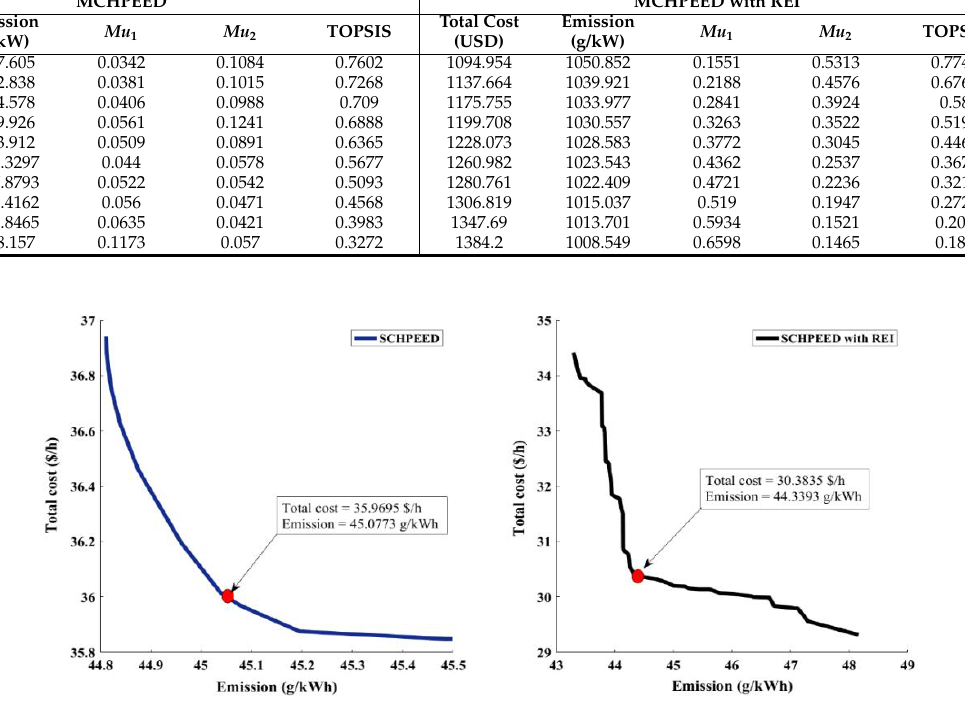
Figure 8. Pareto optimal fronts for SCHPEED and SCHPEED with REI.